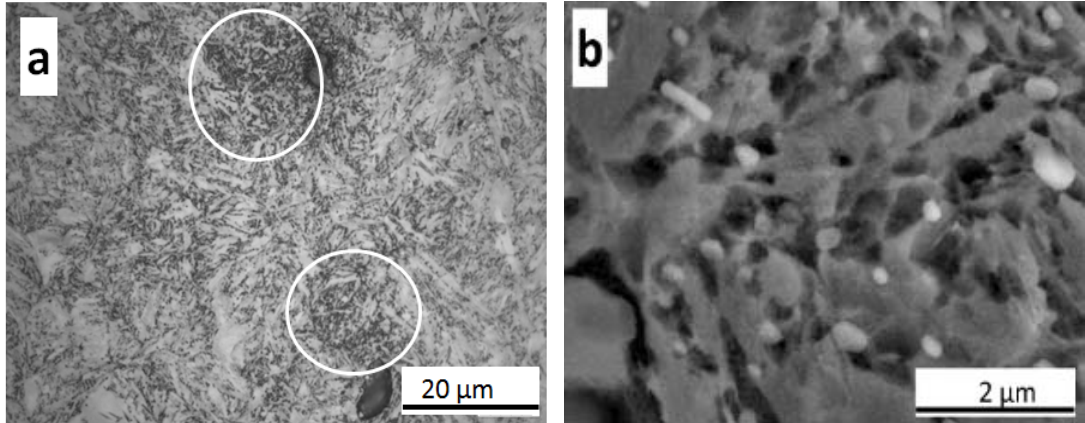
Figure 8. Micrographs of the as-quenched microstructure: ( a ) LOM and ( b ) FEG-SEM. Microstructures have been etched with Vilella reagent. The presence of undissolved cementite in the interdendritic regions (small black points in white circle in Figure 8a and light white/grey ellipsoidal particles in Figure 8b) can be observed.